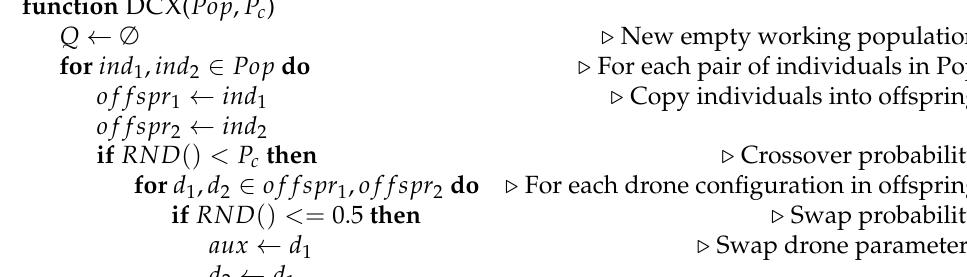
Algorithm 4 Pseudocode of the drone crossover (DCX).